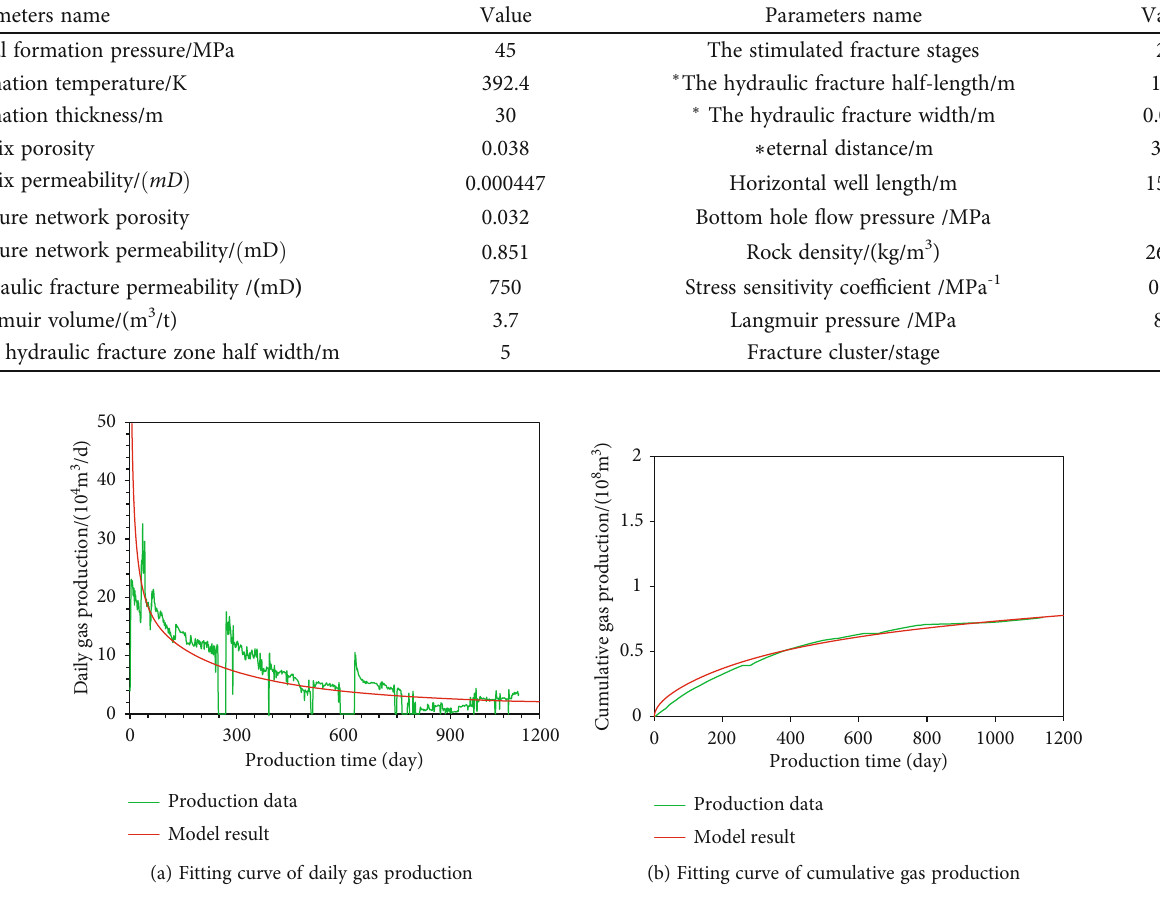
Figure 2: Model veri fi cation